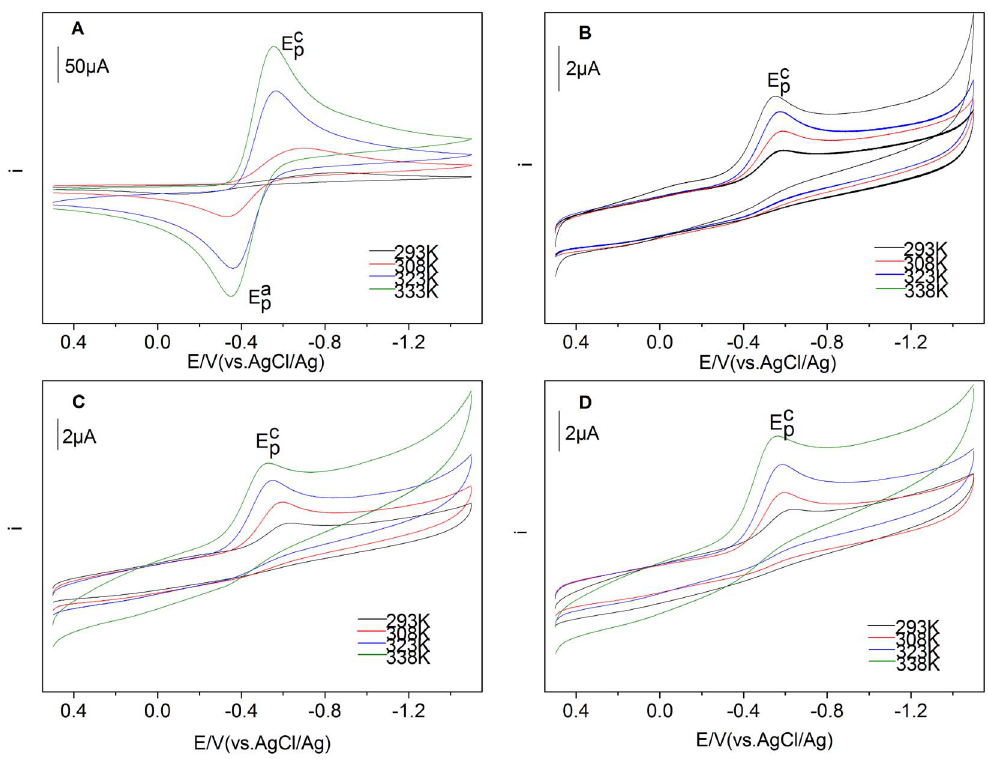
Figure 2. Cyclic voltammograms of Eu(III) (A), Sm(III) (B), Dy(III) (C) and Nd(III) (D) measured in BmimBr at different temperatures.